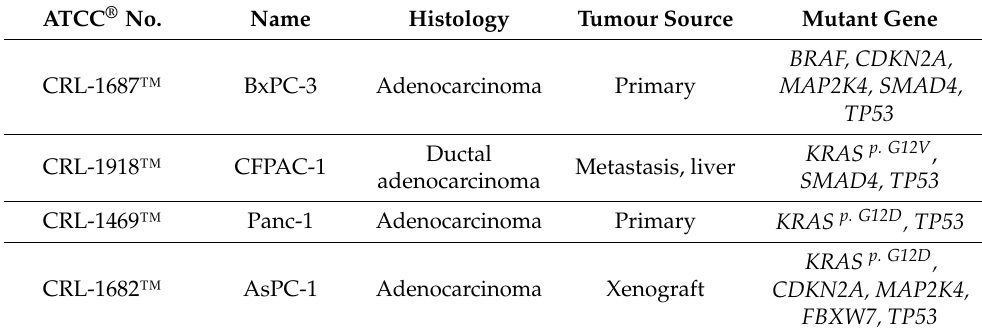
Table 1. Pancreatic cancer cell lines. ATCC ®